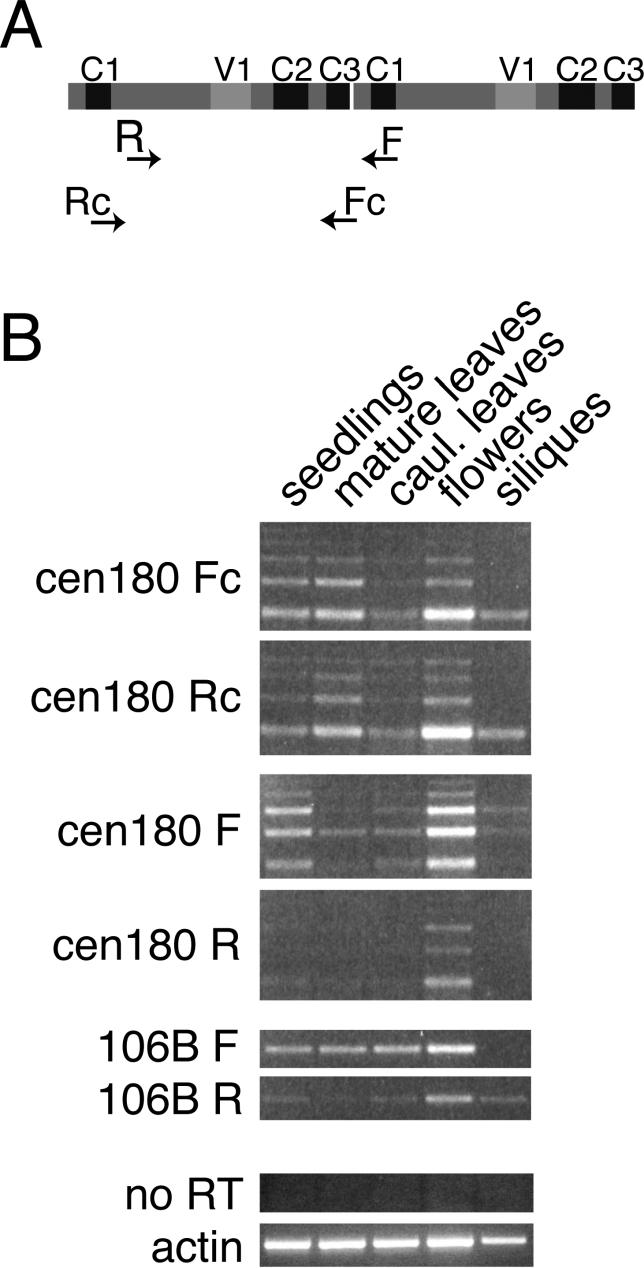
Transcripts from Centromeric Repeats in Landsberg erecta
(A) cen180 repeats and oligonucleotide primers used in RT-PCR. C1, C2, and C3 are regions of conserved DNA sequence; V is a region of variable sequence. Fc and Rc primers were selected from the conserved regions.(B) RT-PCR of cen180 and 106B repeat transcripts. RT was performed using the primers indicated, followed by PCR with the first primer and a corresponding primer on the other strand. Fc and Rc detect transcripts derived from both strands of bulk repeats, but the F primer detects strand-specific transcripts belonging to a subfamily of these repeats. Primers recognizing ACTIN2 transcripts served as positive controls. Negative controls lacking reverse transcriptase (“no RT”) tested for DNA contamination.